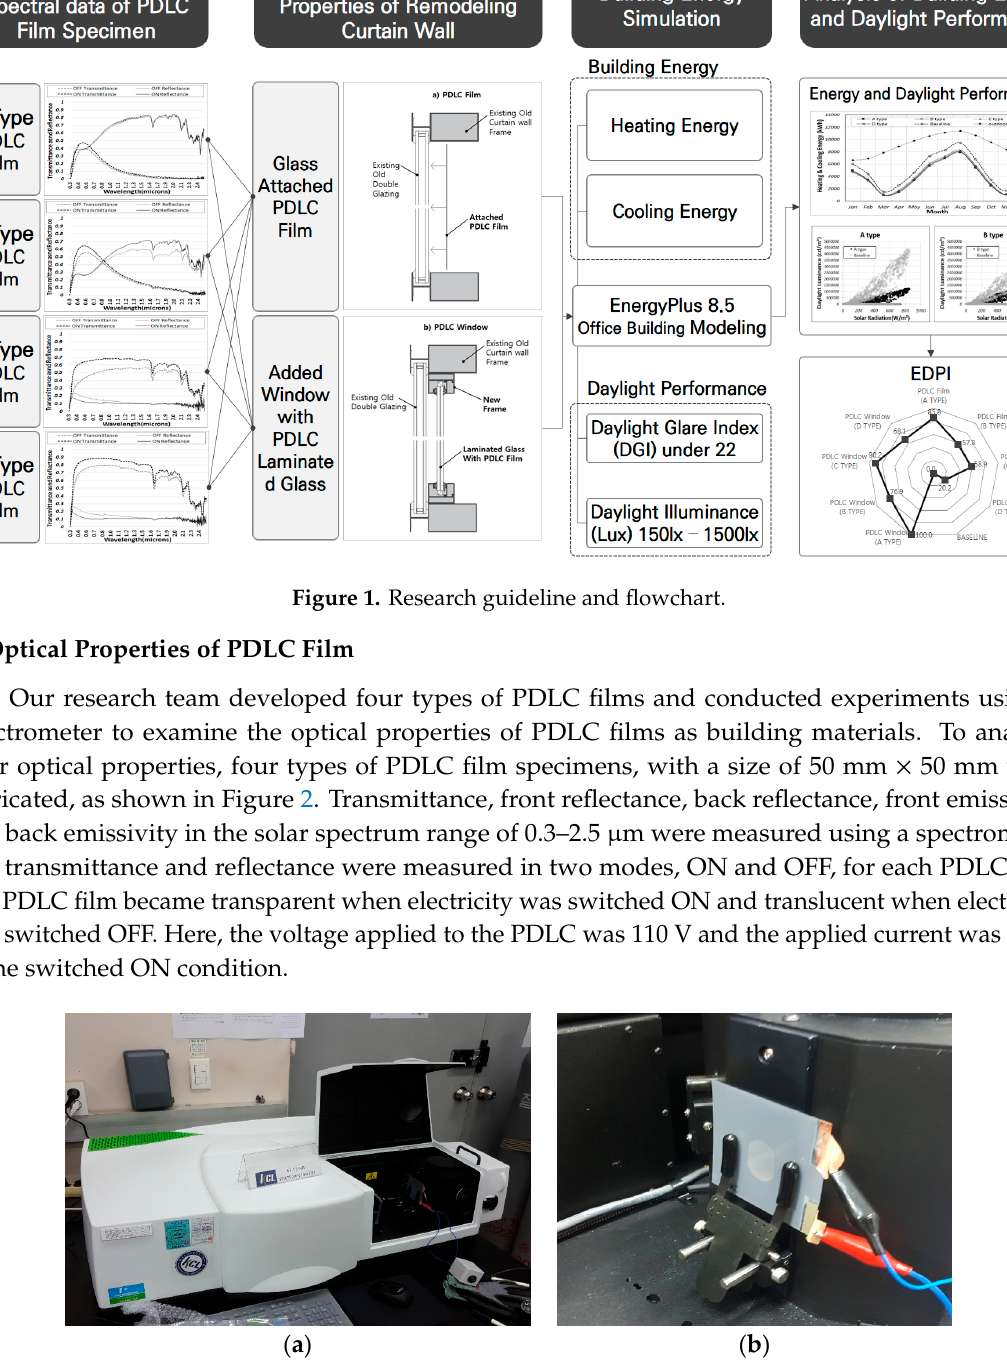
( d ) Figure 3. Optical properties data by PDLC film type. Table 1. Optical properties data by PDLC film type derived using Lawrence Berkeley National Laboratory (LBNL) Optic 6 program. Division